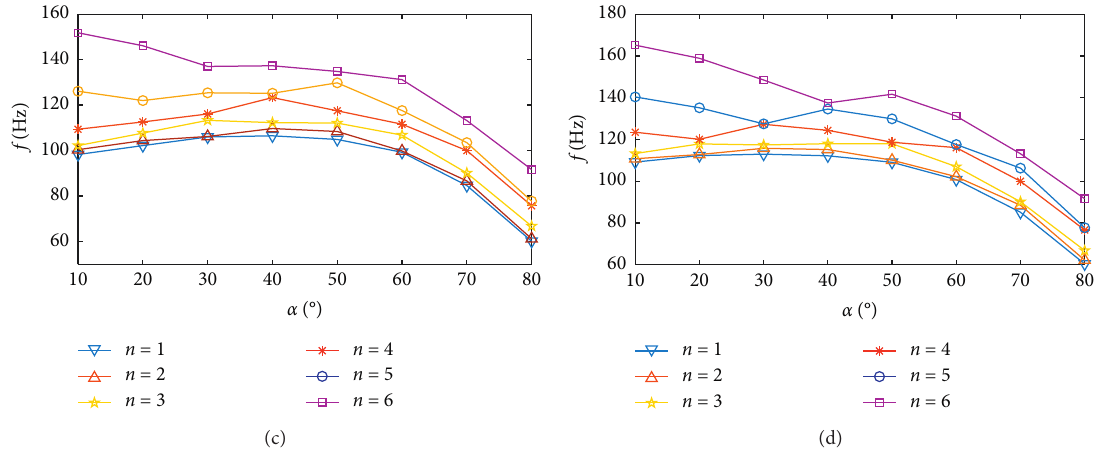
Figure 8: Frequency curves of the first six orders of conical shell with different half-cone angles. (a) C–F. (b) S–S. (c) S–C. (d) C–C. Table 5: Frequency of conical shell with different length-diameter ratios (Hz). Boundary